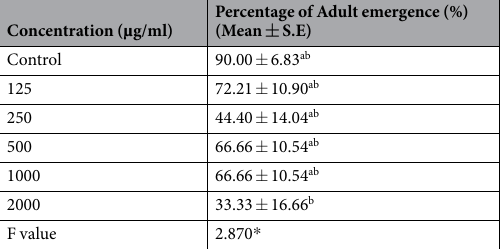
Table 4. Influence of ethyl acetate extract of S. commune on percentage of adult emergence of S. litura . The values are mean ± standard error. Significance ascribed as * p < 0.05 and ** p < 0.01 (One way ANOVA). Different letters a, b within the column are significantly different (Tukey’s test, p ≤ 0.05) and signify the effect of